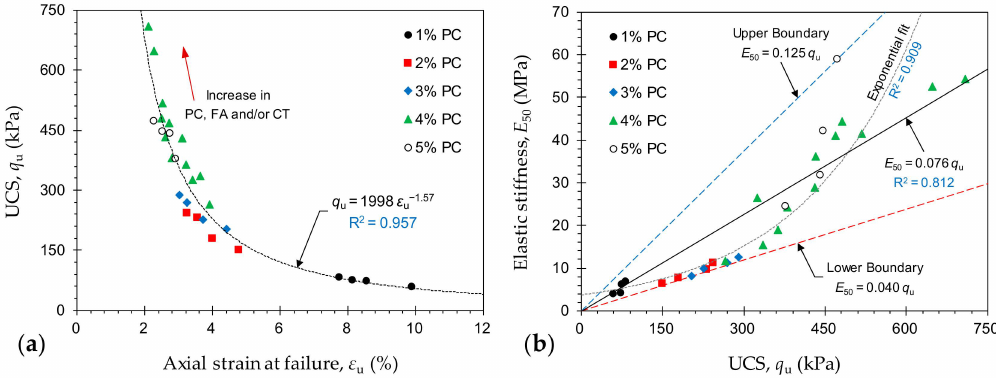
Figure 5. ( a ) Variations of UCS against axial strain at failure ε u —obtained by the external LVDTs—for the tested mix designs (CT = curing time); and ( b ) Variations of E 50 against UCS for the tested mix